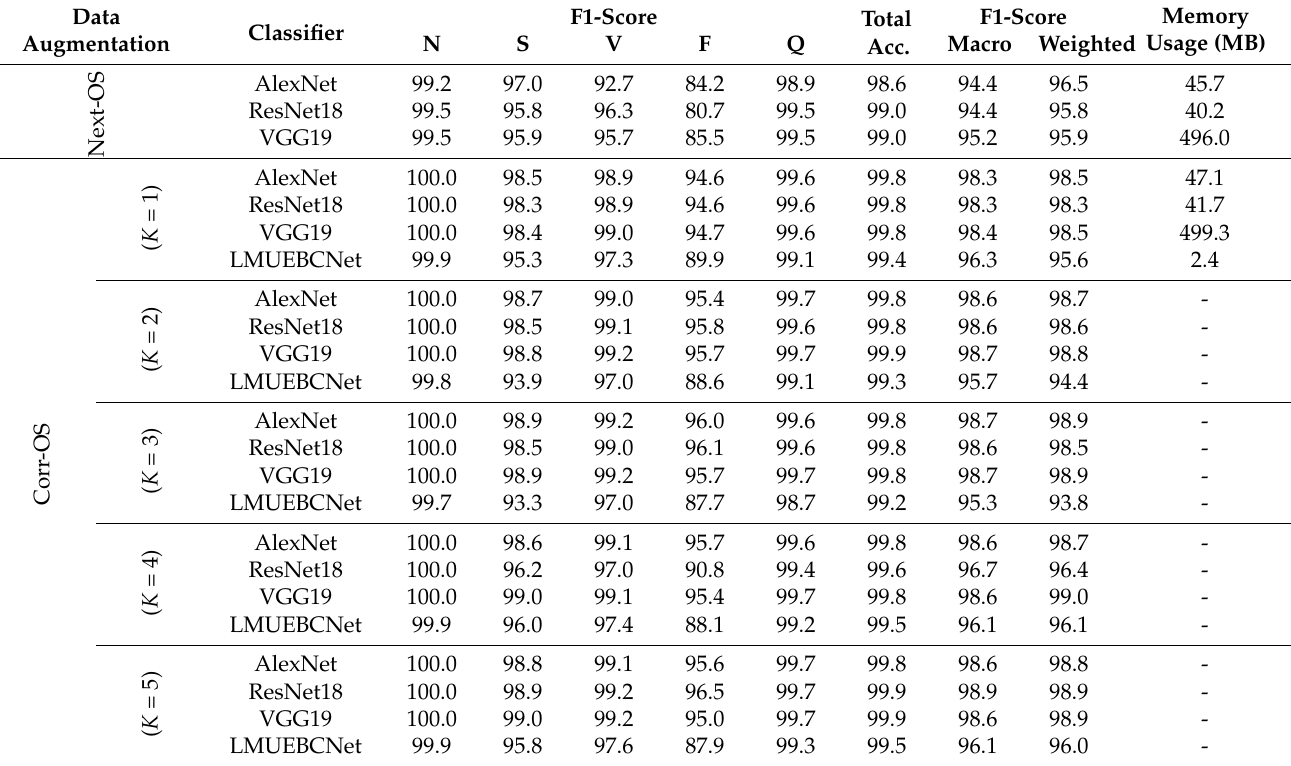
Table 5. Classification performance between LMUEBCNet with existing models using Corr-OS/Next- OS dataset under